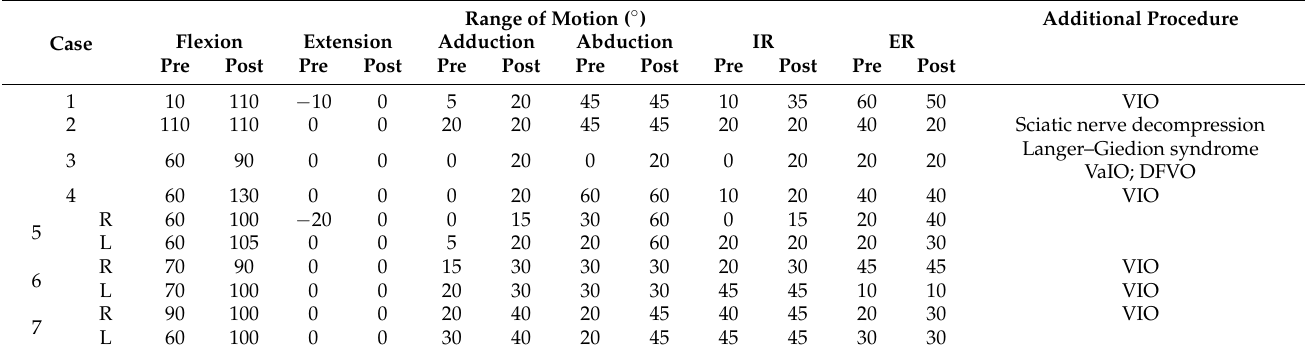
Table 2. Changes in range of motion of the hip